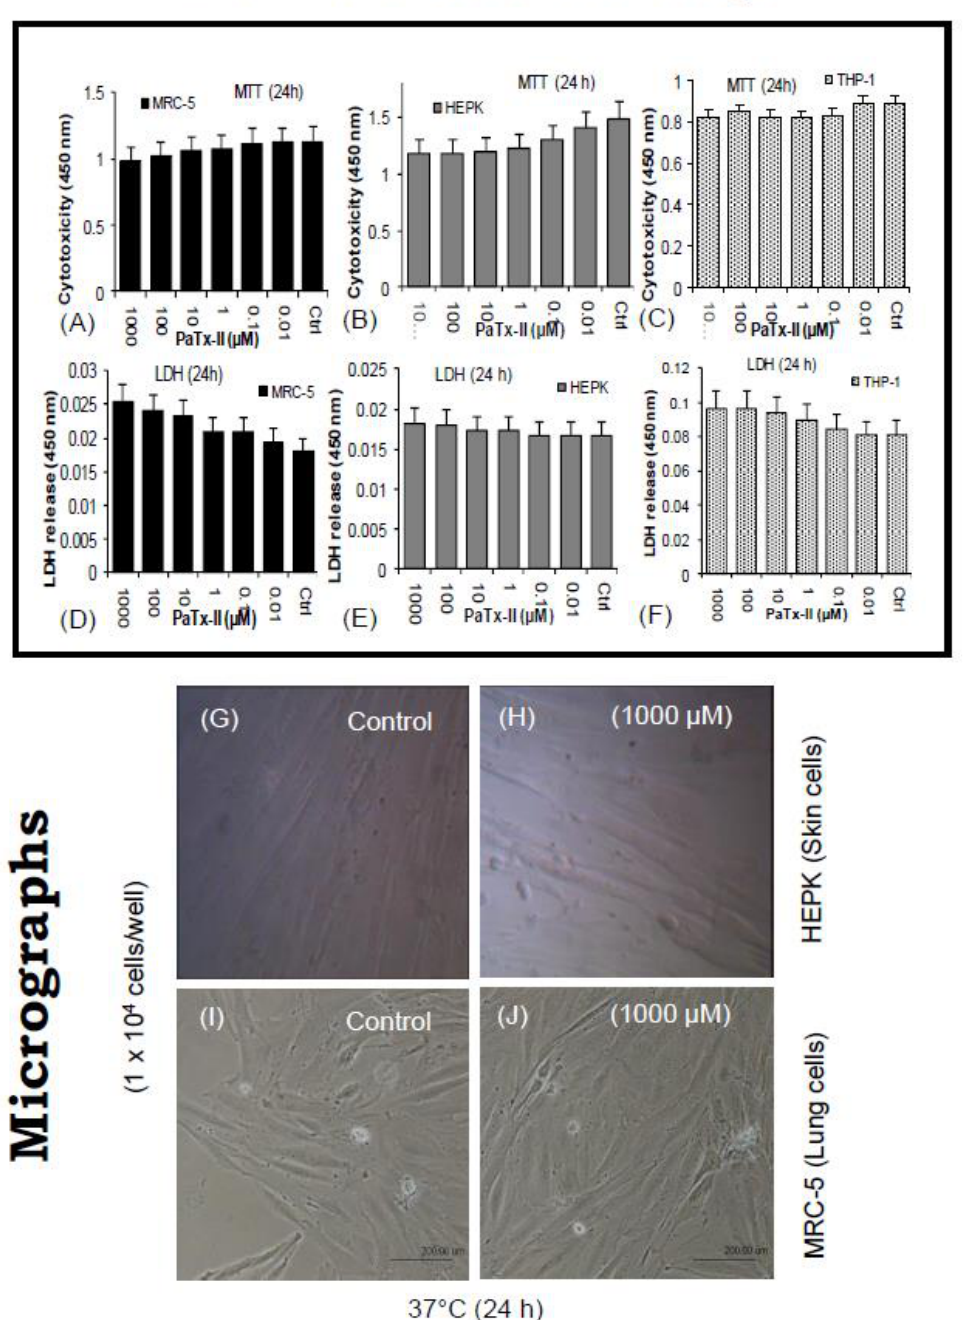
Figure 3. Cytotoxicity of the PaTx-II protein on cultured lung (MRC-5), skin fibroblasts (HEPK), and human macrophage (THP-1) cells incubated with 0.1 – 1000 µM doses for 24 h. ( A – C ) Cytotoxicity was measured by the MTT assay, and results reveal that PaTx-II did not induce dose-dependent toxic effects, even at higher doses (1000 µM). The untreated cells are included as controls. ( D – F ) Lactate dehydrogenase (LDH) released from cells. PaTx-II did not induce cell death or lytic effects at all assayed concentrations. Data represent the mean ± standard deviation (SD) of the three independent replicates (n = 3). ( G , H ) Light micrographs showing the cellular morphology in the presence of PaTx-II. ( G , I ) Control cells show normal morphology, ( H , J ) PaTx-II-treated skin and lung fibroblasts did not induce any morphological changes after 24 h.